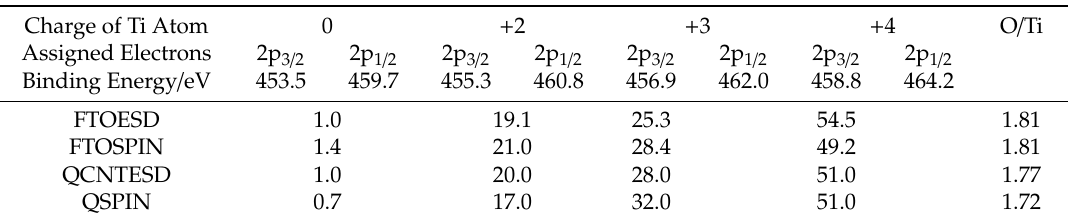
Table 3. Binding energies obtained by deconvolution of XPS peaks assignable to Ti 2p electrons, percentages of the Ti 0 , Ti 2 + , Ti 3 + , and Ti 4 + species in total Ti atom, and O / Ti ratios of the heat-treated thin films on two di ff erent glass substrates prepared via the ESD and spin-coating processes, FTOESD, FTOSPIN, QCNTESD, and